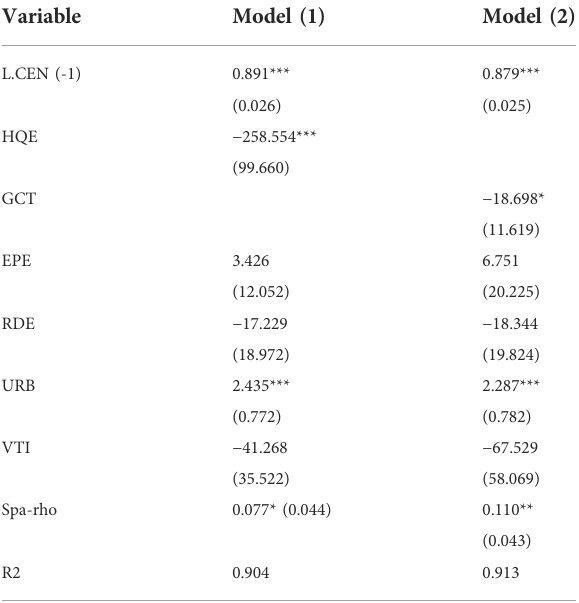
TABLE 7 Regression results of the impact of high-quality economic development and green credit on carbon emissions.